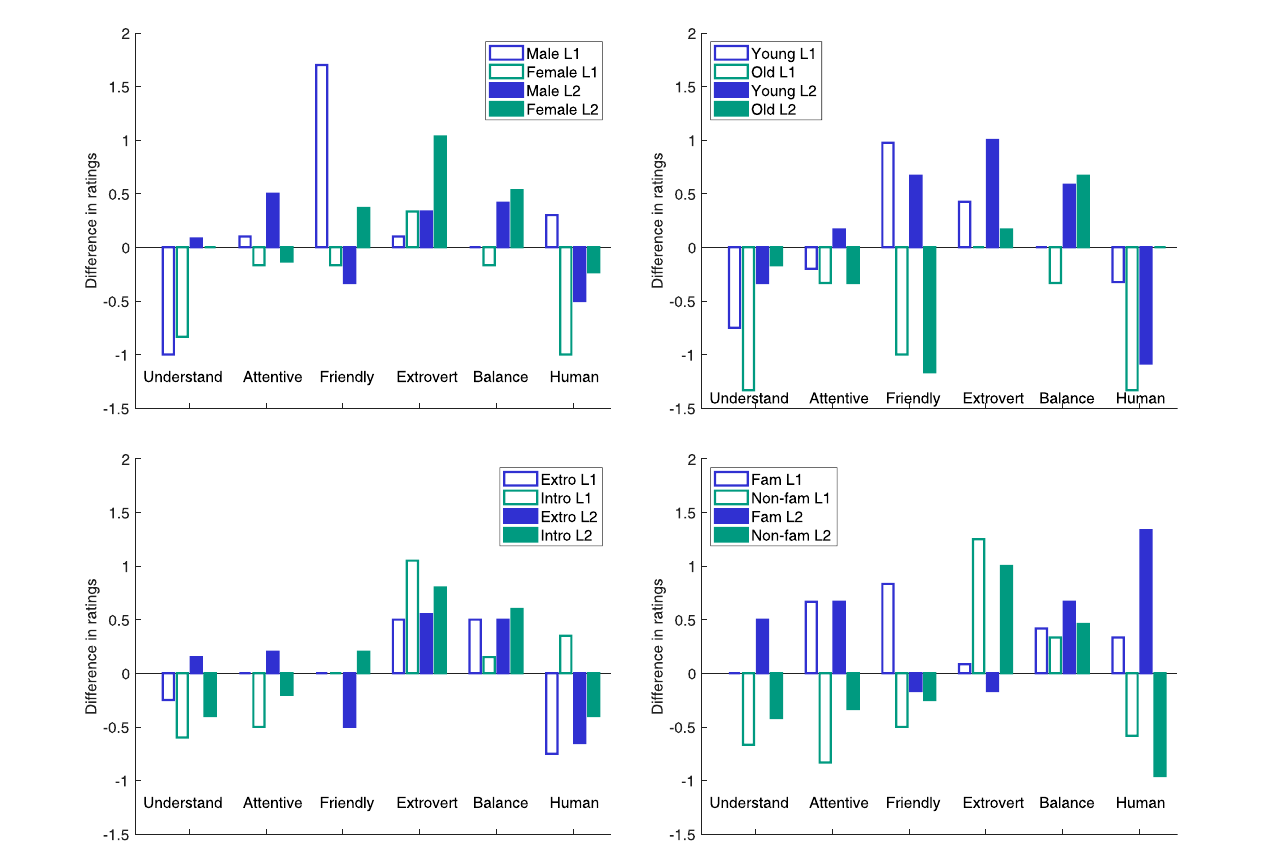
FIGURE 5 Differences in five point Likert scale ratings between Experimental and Control conditions depending L1 or L2 speaker, in combination with Upper left: male or female, Upper right: younger or older than the mean age in the group, Lower left: more (Extro) or less (Intro) extrovert than the mean level in the group or Lower right: more (Fam) or less (Non-fam) familiar with robots than the group